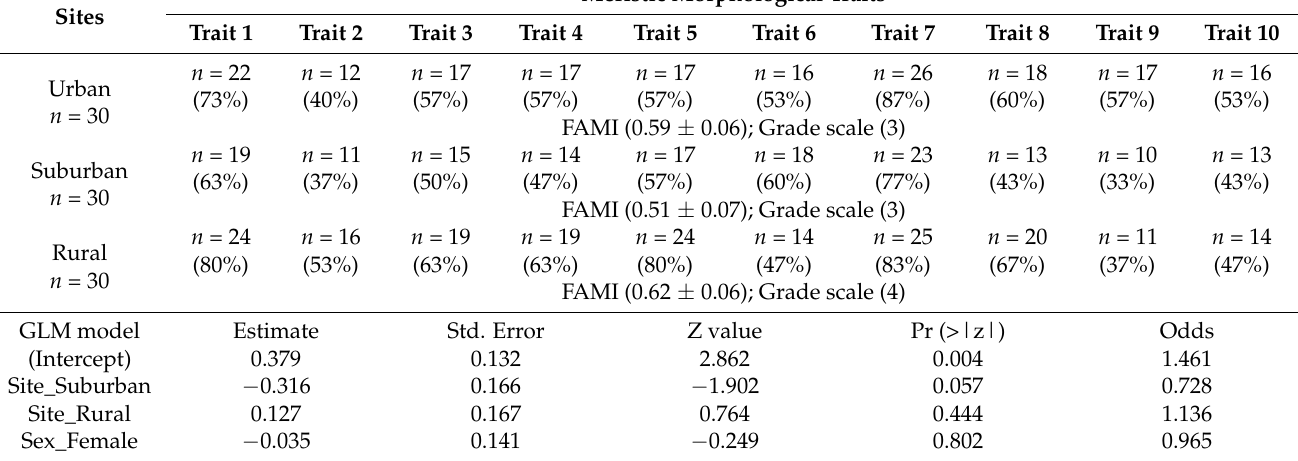
Legend: n —number of individuals; trait 1—number of stripes on the dorsal side of the thigh (femur); trait 2—number of spots on the dorsal side of the thigh; trait 3—number of stripes on the dorsal side of the shank (crus); trait 4—number of spots on the dorsal side of the shank; trait 5—number of stripes on the foot (pes); trait 6—number of spots on the foot; trait 7—number of stripes and spots on the back (dorsum); trait 8—number of white spots on the ventral side of the second finger of the hind leg; trait 9—number of white spots on the ventral side of the third finger of the hind leg; trait 10—number of white spots on the ventral side of the fourth finger of the hind